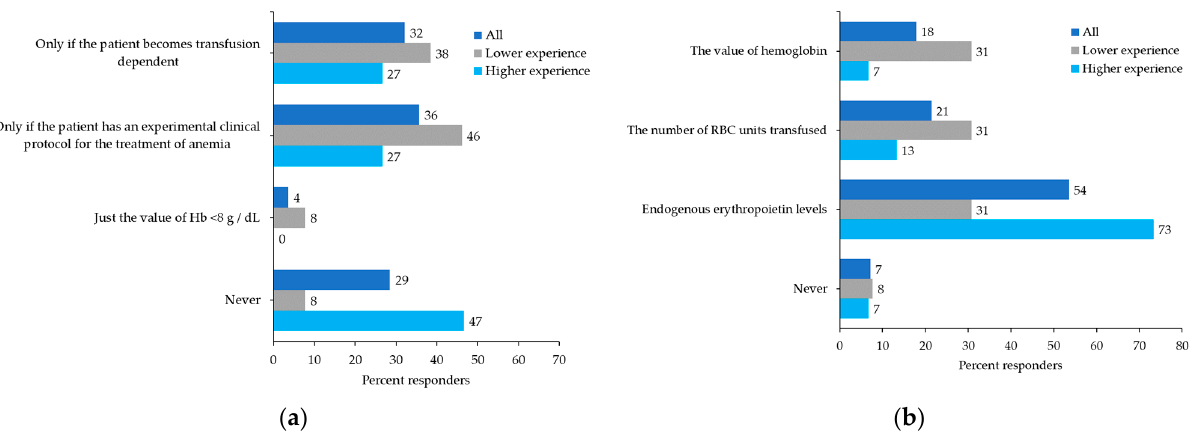
Figure 5. Participant preferences: ( a ) In a patient with MF receiving ruxolitinib and clinical response (CR, PR) but with anemia, when do you feel it is necessary to stop or reduce the dose of treatment? ( b ) In a patient with MF receiving ruxolitinib and clinical response (CR, PR) but developing anemia, which do you think is the best parameter for deciding to combine an erythropoietin stimulating agent (ESA)?